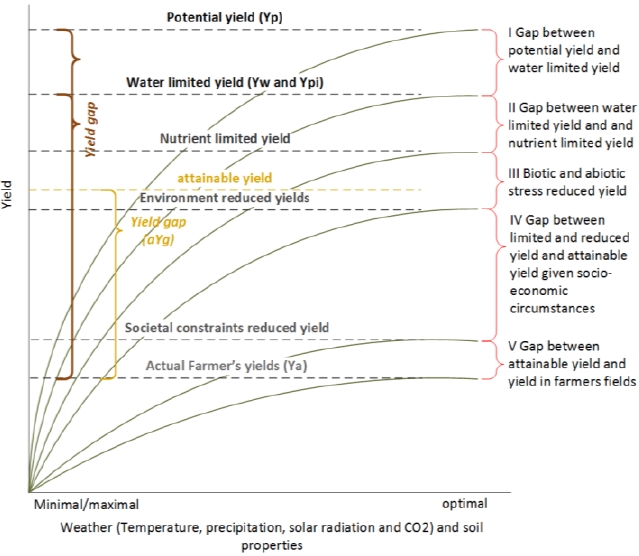
Figure 5. Graphical presentation of the various factors contributing to the yield gap. Actual yield is often limited by many interacting factors. Attempts have been made to incorporate this by introducing the concept of attainable yield, and the attainable yield gap. This is defined in terms of the best local [280] or global [281] practices, under similar biophysical and climatological circumstances.